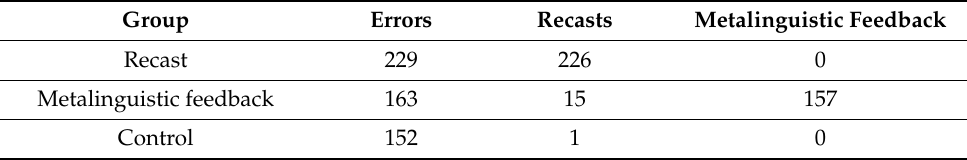
Table 2. Distribution of error and CF moves during interaction.